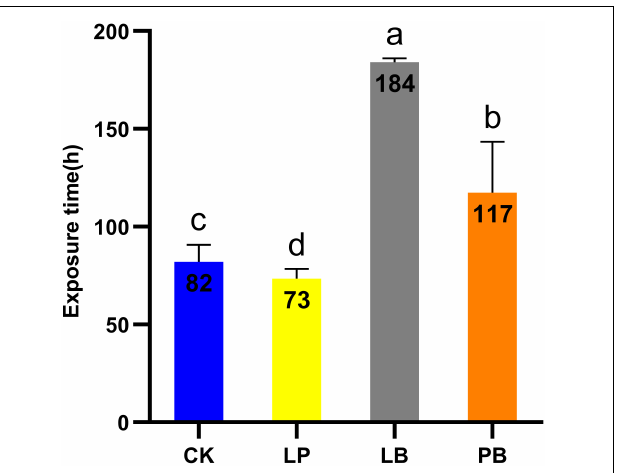
FIGURE 1 | Time required to exceed room temperature 2 ◦ C during aerobic exposure of Leymus chinensis silage. CK, no additive control; LP, Lactobacillus plantarum ; LB, Lactobacillus buchneri ; PB, Lactobacillus plantarum + Lactobacillus buchneri . Different lowercase letters indicate significant differences among different treatment ( P <